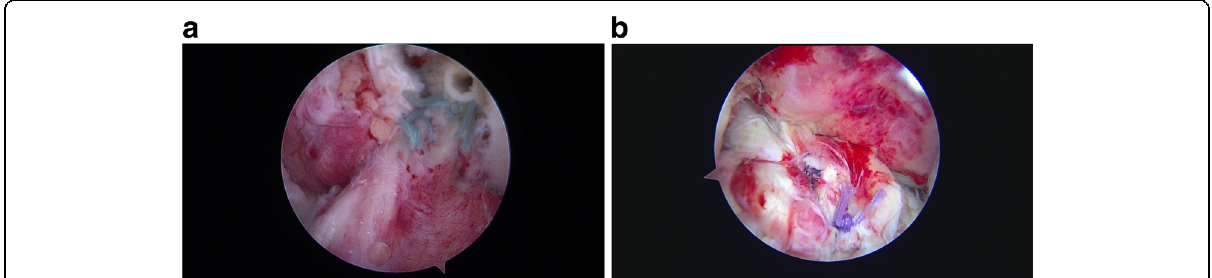
Fig. 13 a. Proximal ACL repair. b. Distal ACL